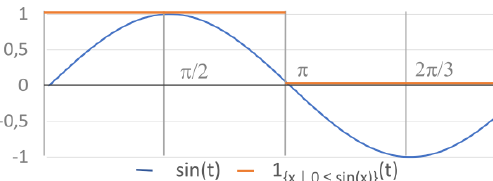
Figure 1. sin -function and the corresponding state function 1 { x ∣ 0 ⩽ sin ( x )}